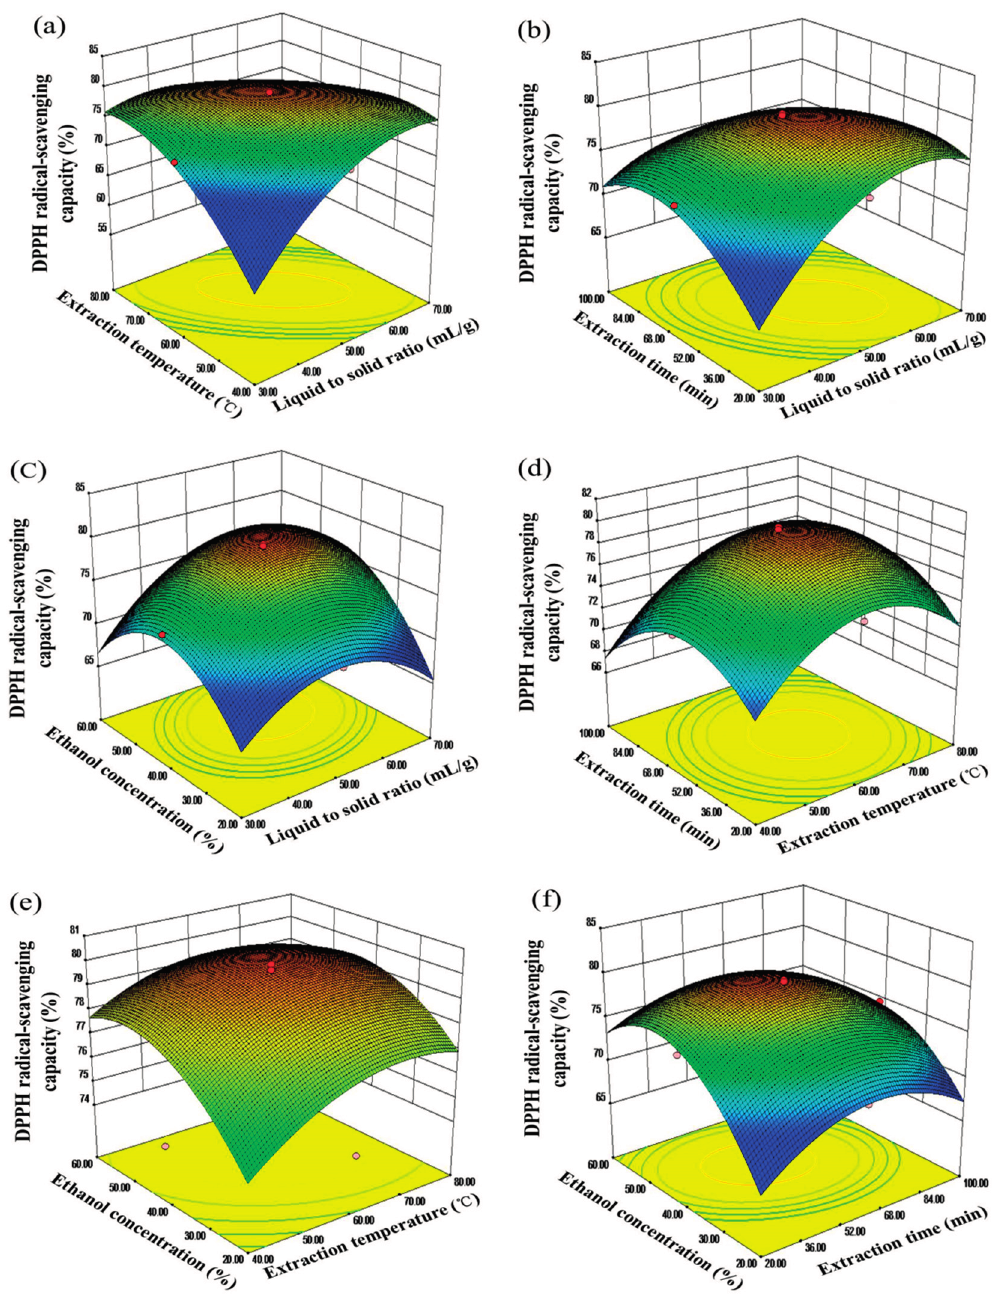
Figure 7. Response surface plots (3D) showing the effects of the extraction parameters on DPPH radical-scavenging capacity of alfalfa extracts. ( a ) liquid to solid ratio and temperature; ( b ) liquid to solid ratio and time; ( c ) liquid to solid ratio and Ethanol concentration; ( d ) time and temperature; ( e ) temperature and ethanol concentration; ( f ) time and ethanol